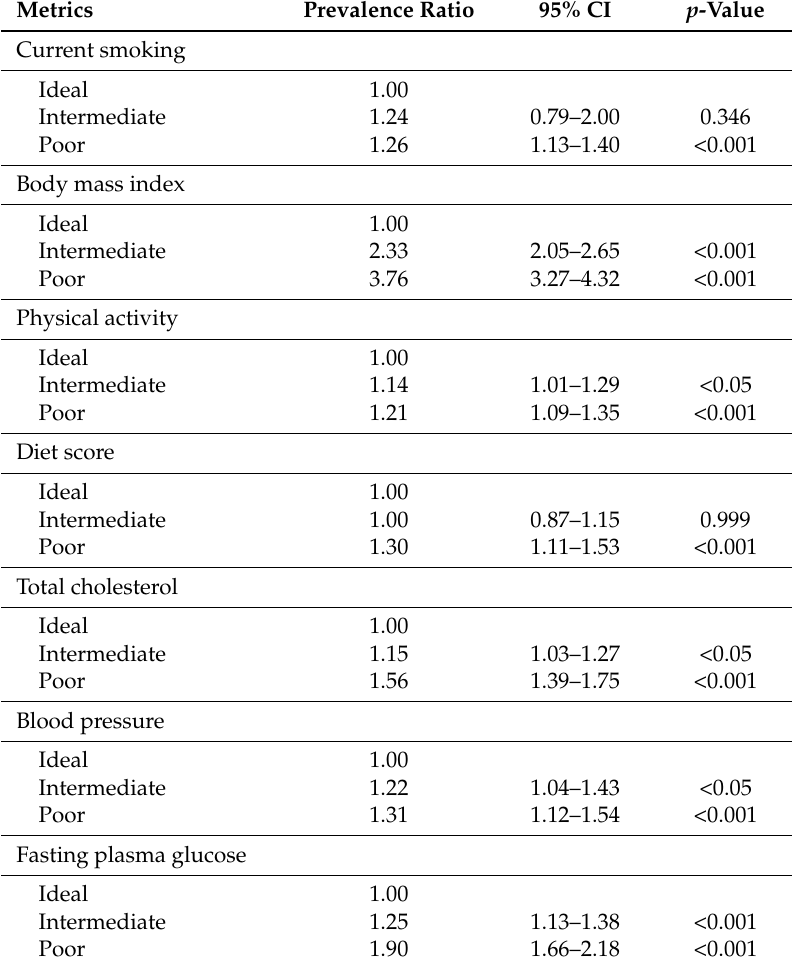
Table 3. Log binomial regression on the association between each CVH metric and having a high AIP a